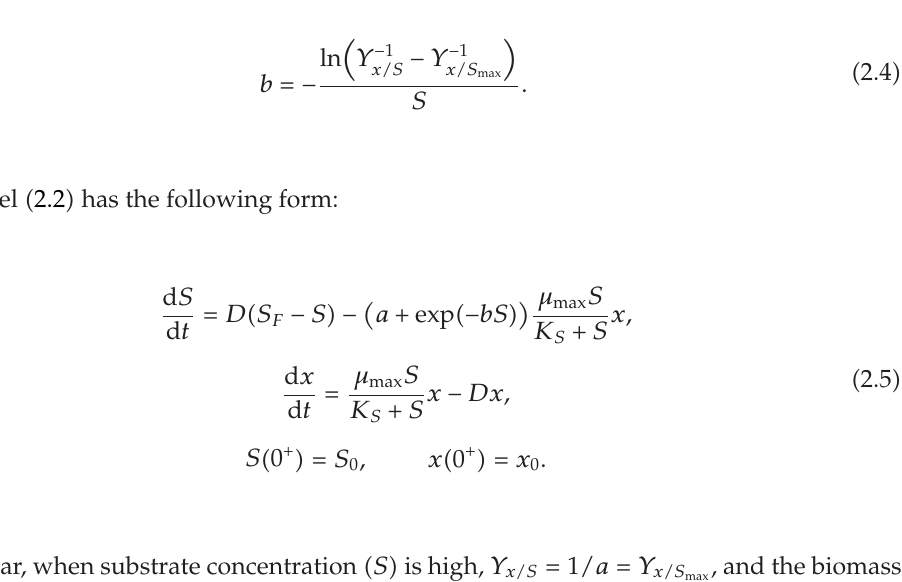
Figure 1: The biomass yield for Y x/S b (cid:7) 1 . 5 (cid:6)